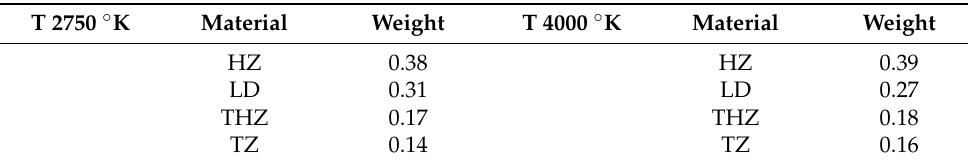
Table 4. Hierarchy after Saaty’s analysis. T 2750 ◦ K Material Weight T 4000 ◦ K